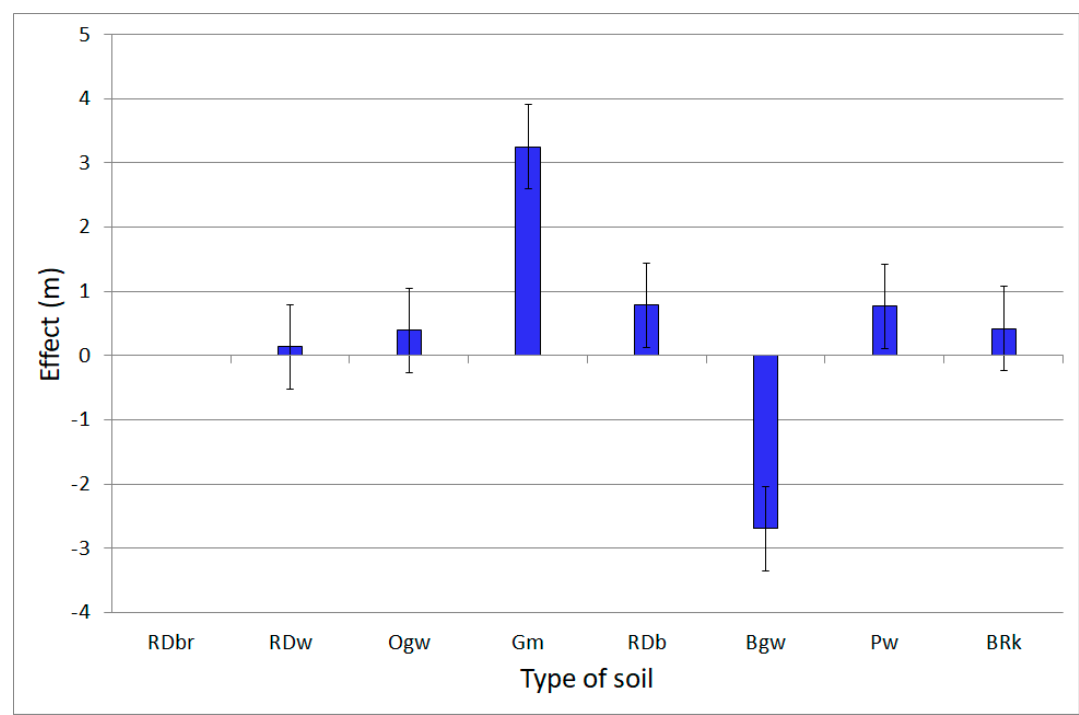
Figure 4. Partial effects of the soil types on the site index for oak; the effect is displayed with all other factors held constant. Mean differences and error bars represent the parameters of the generalized additive model and its confidence interval. Legend: RDbr, rusty brown soils; RDw, proper rusty soils; Ogw, gleysols; Gm, gley-podzol mucky soils; RDb, podzolised rusty soils; Bgw, gley-podzol soils; Pw, clay-illuvial soils; BRk, acid brown